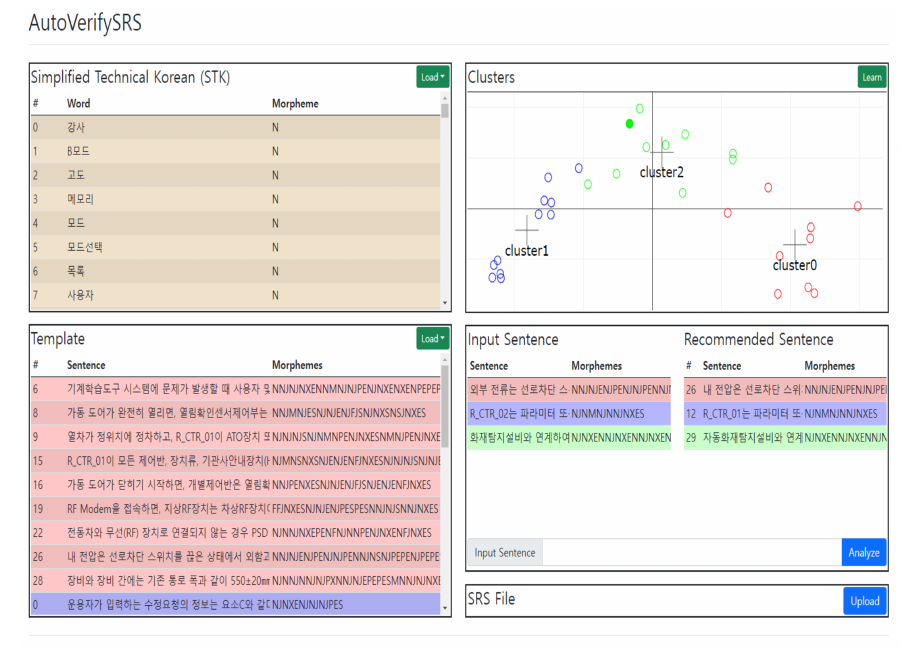
Figure 3. Automated checker for the correctness of requirement